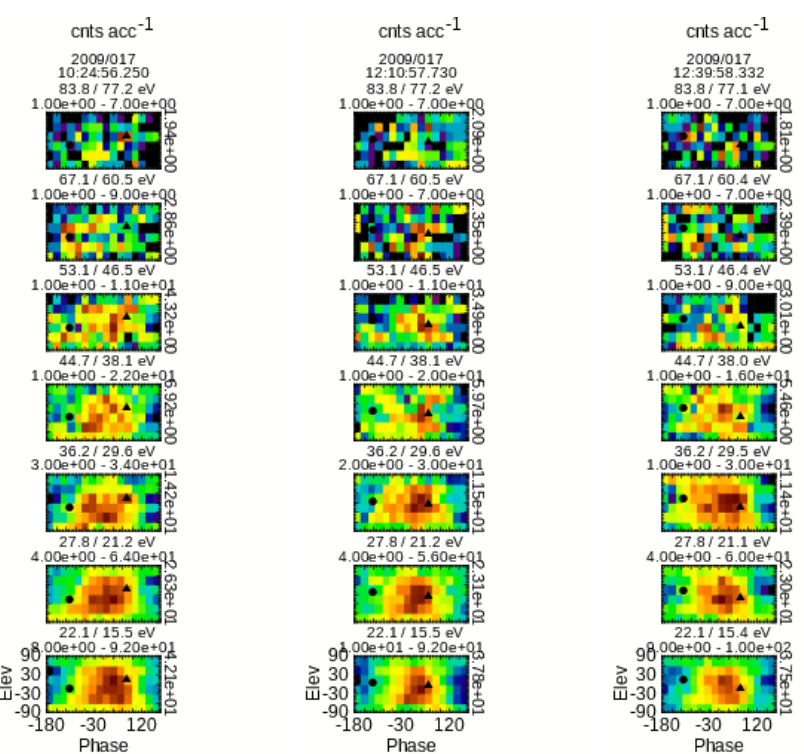
Figure 5. φ – θ plots in units of cntsacc − 1 . Each column of plots corresponds to the column of plots in Fig. 4. The plots are auto-scaled and the maximum cnt/acc scaling above each plot provides the highest count level. The value to the right of each plot is the average counts per cell in the data